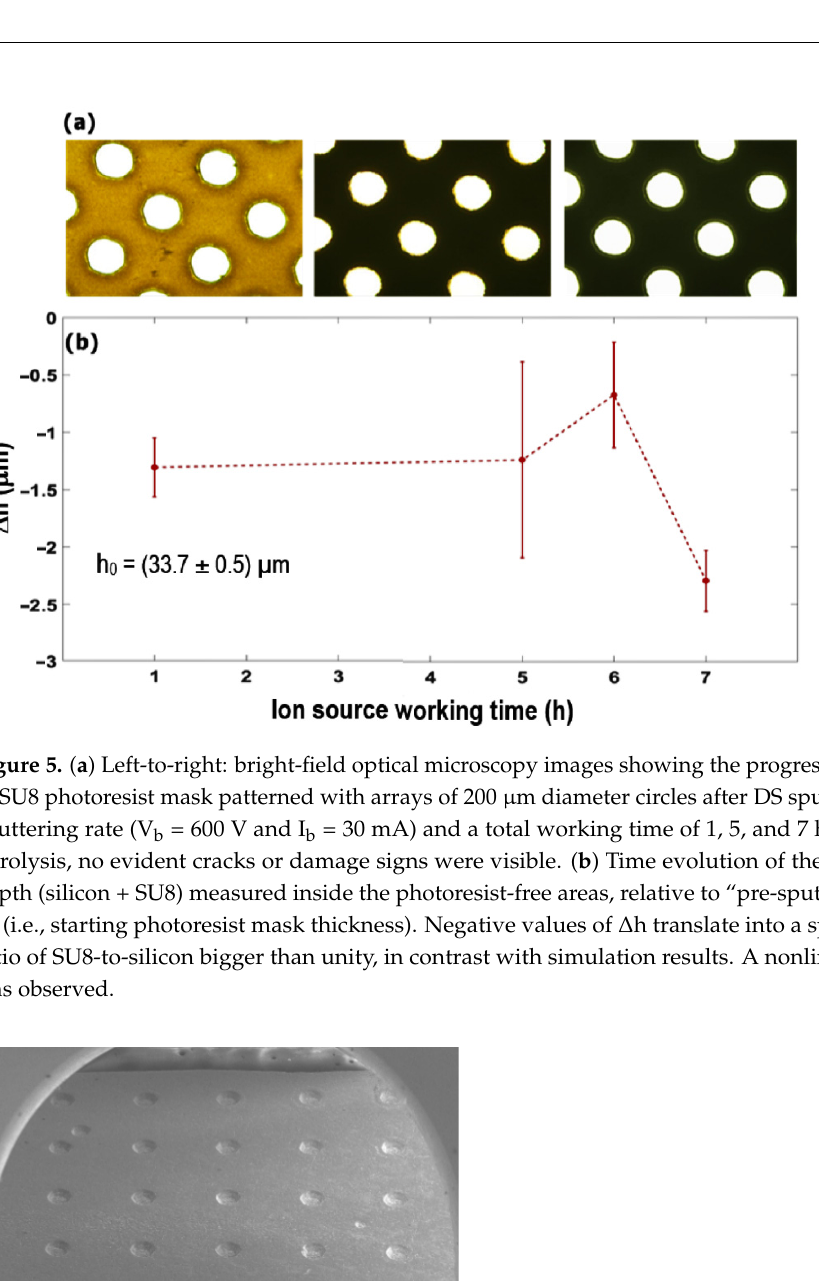
Figure 6. SEM image partial overview of a set of micromembranes patterned on T91 steel by means of DS, after the removal of photoresist mask residuals.